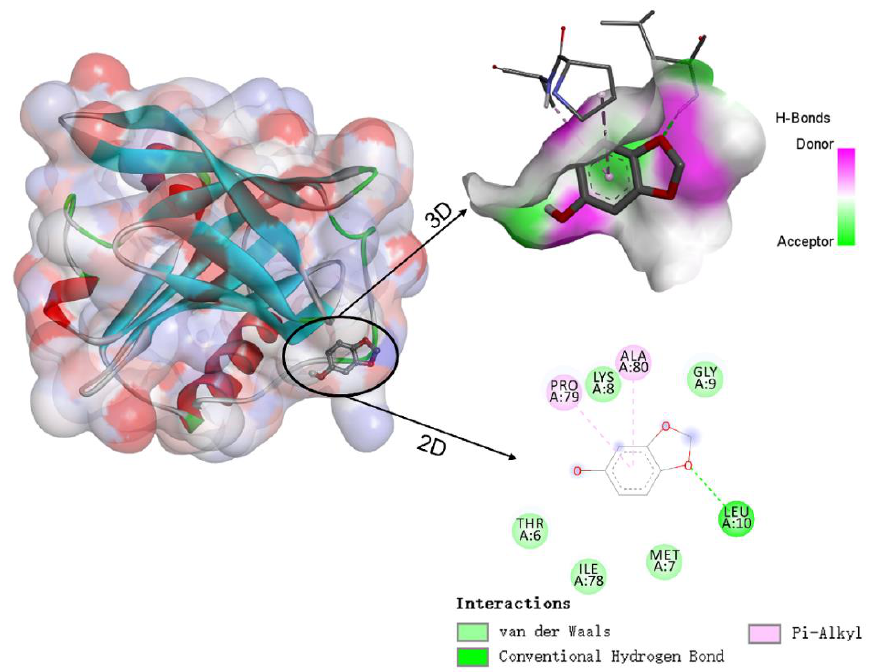
Figure 6. Schematic diagram of the 3D docking model and 2D interaction between β -lactoglobulin (β -LG) and sesamol.